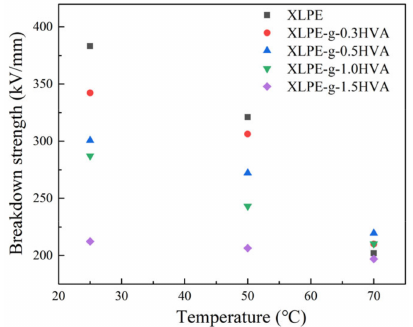
Figure 7. DC breakdown strength curves of XLPE and HVA-2 grafted XLPE as a function of temperature.